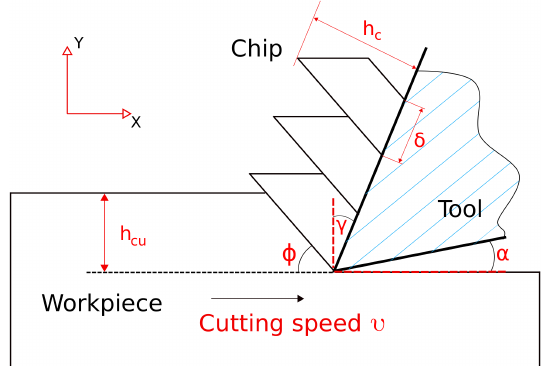
Figure 1. Orthogonal machining parameters; cutting speed v , uncut chip thickness h cu , chip thickness h c , chip compression ratio λ = h c / h cu , shear angle φ , rake angle γ , clearance angle α , chip segmentation distance δ